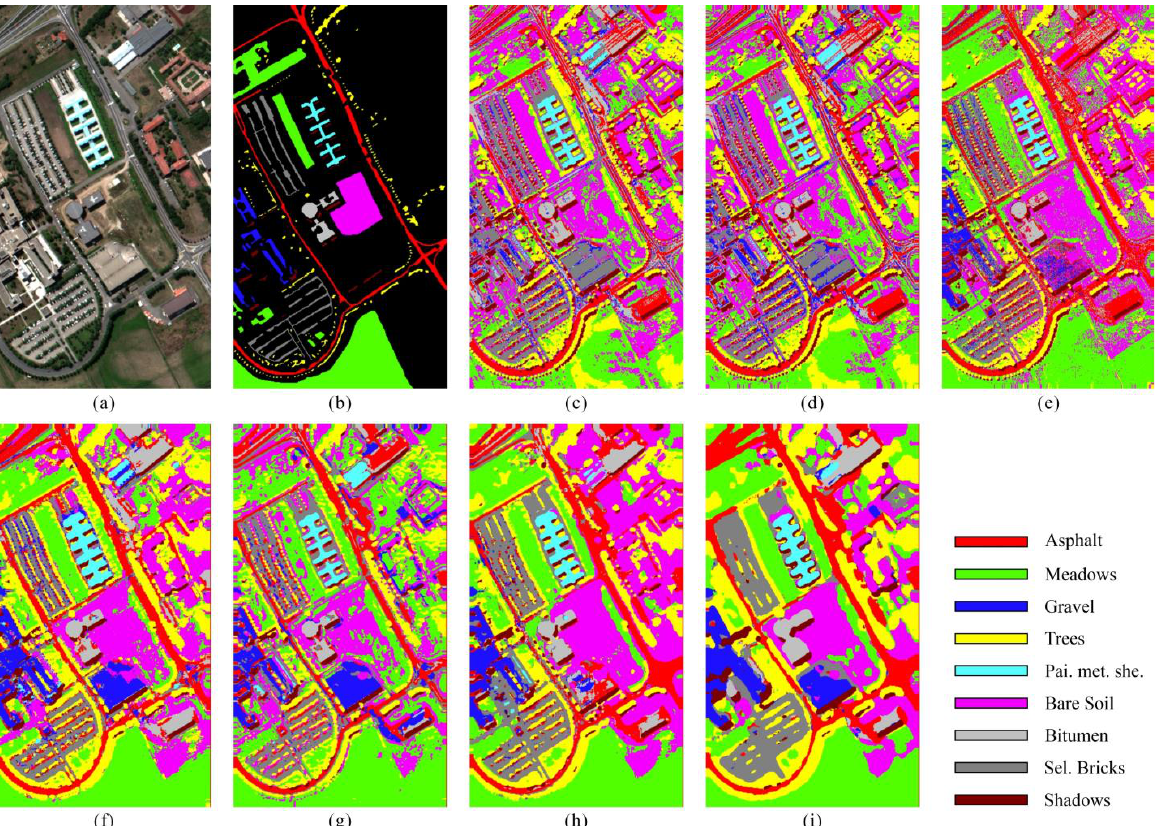
Figure 9. The classification results obtained using different methods on the Pavia University dataset. ( a ) Three-band composite image of the Pavia University HSI. ( b ) The ground truth of Pavia University HSI. The classification results of ( c ) SVM, ( d ) 1D CNN, ( e ) R2D, ( f ) 2D CNN, ( g ) 3D CNN, ( h ) MCM, and ( i ) LGSF.